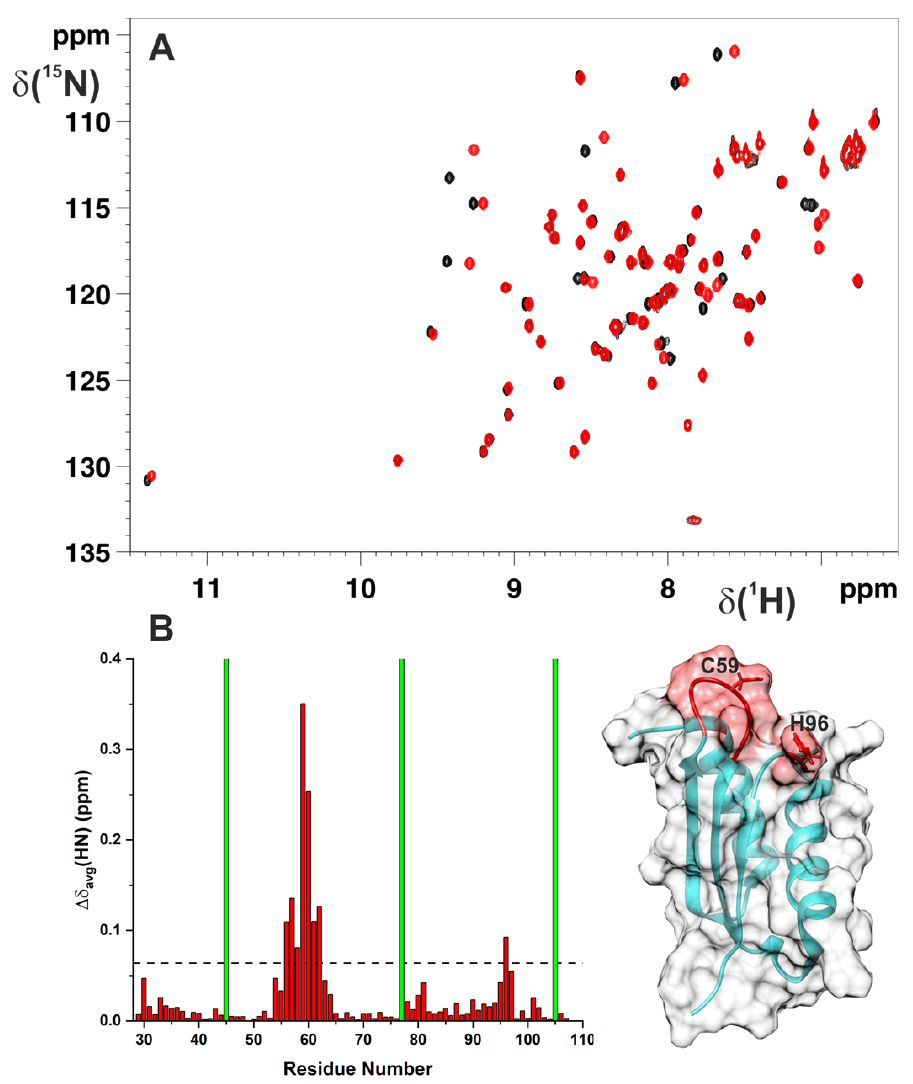
Figure 1. C59Y mutation structurally perturbed only the Fe–S cluster-binding region of BOLA3. ( A ) Overlay of the 1 H − 15 N HSQC spectra of 15 N-labelled BOLA3 (black) and 15 N-labelled C59Y BOLA3 (red). The 1 H − 15 N HSQC spectra were acquired at 298 K in 150 mM NaCl, 5 mM GSH, 5 mM DTT, 50 mM phosphate buffer (pH 7.0), and 10% ( v/v ) D 2 O. ( B ) Backbone weighted average chemical shift differences ( ∆ δ avg (HN)) between BOLA3 and C59Y BOLA3. A chemical shift threshold value of 0.06, indicated as a dashed line, was estimated to define meaningful chemical shift differences (see the Materials and Methods section). The green bars indicate proline residues or unassigned NHs. The meaningful chemical shift differences are mapped in red on the solution structure of BOLA3 (PDB 2NCL). The side-chains of Cys59 and His96 Fe–S cluster ligands are depicted in red sticks. As following step, chemical shift perturbations and line broadening analyses were performed by comparing the 1 H − 15 N HSQC spectra of 15 N-labelled BOLA3 and 15 N- labelled C59Y BOLA3, respectively, with those recorded in presence of equimolar amounts of apo GLRX5, at two different starting concentrations of 15 N-labelled BOLA3 and 15 N- labelled C59Y BOLA3 (100 and 800 µ M). The observed spectral changes were then mapped on the solution structures of BOLA3 (PDB 2NCL) and on a structural model of C59Y BOLA3, obtained by homology modelling through MODELLER 9.10 software followed by energy minimization in water through AMBER 12.0 program (see the Materials and Methods section for